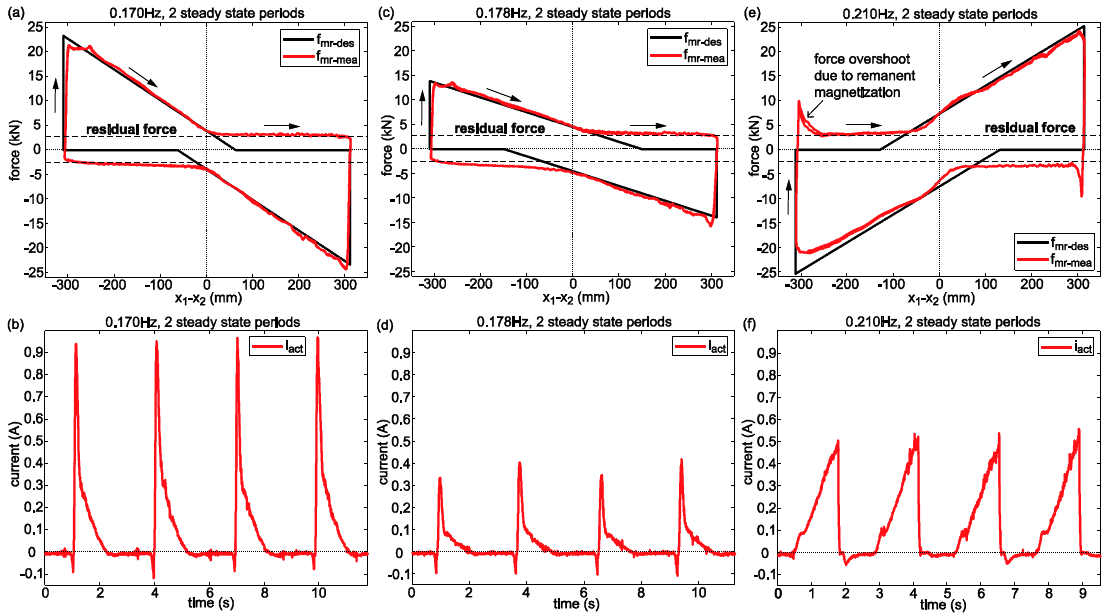
Figure 21. Control force tracking accuracy during two steady state cycles of selected hybrid tests: emulations of ( a , b ) large negative stiffness due to f w << f passive = f 1 − nominal ; ( c , d ) medium negative stiffness due to f w < f passive = f 1 − nominal and ( e , f ) large positive stiffness due to f w >> f passive = f 1 − nominal